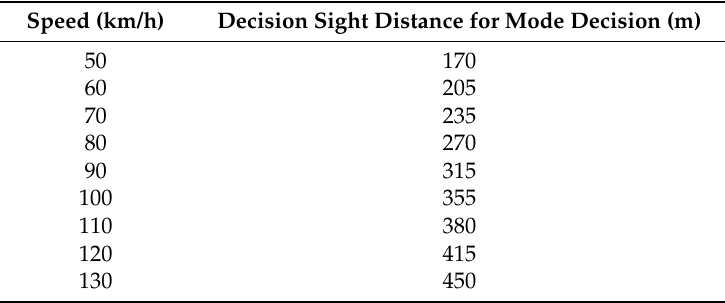
Table 2. Decision sight distance for a range of